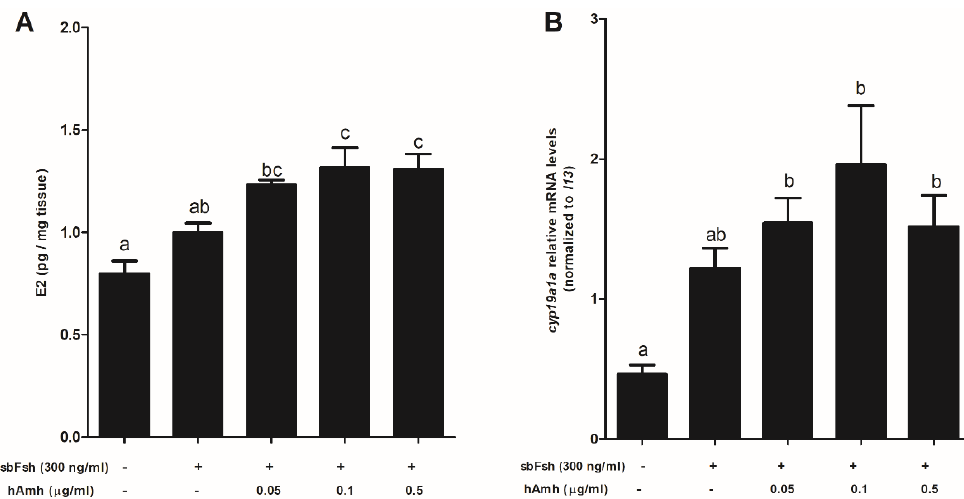
Figure 8. In vitro effect of human AMH and sea bass Fsh on ( A ) E2 levels and ( B ) cyp19a1a expression in previtello- genic/early vitellogenic ovarian explants. Data are shown as the means ± SEM and correspond to four separate experiments ( n = 4) with 6 different replicates each and were analyzed by ANOVA followed by Tukey’s significant interaction test. Statistical differences ( p < 0.05) are indicated with different letters above the bars.